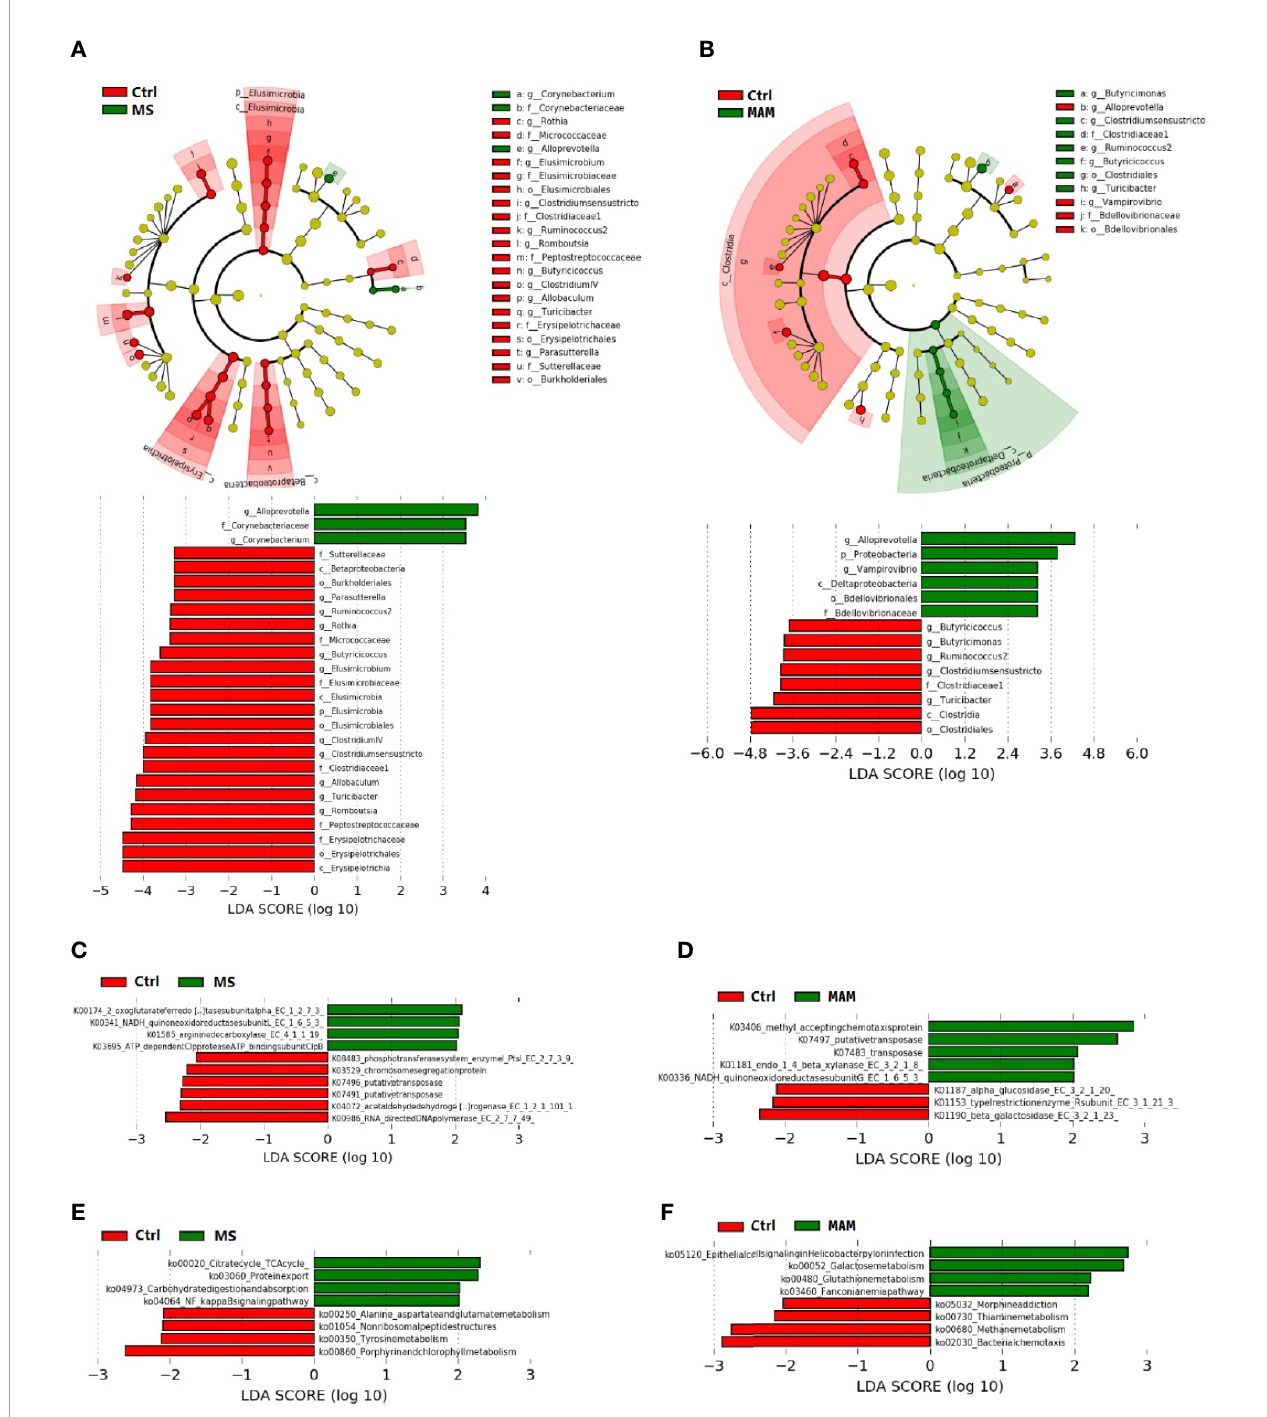
FIGURE 5 | Linear discriminant effect size (LEfSe) analyses comparing differentially abundant taxa and the KEGG-based ortholog functions and pathways between control and MS group communities and control and MAM group communities. (A, B) The differences in gut microbiota taxa between different model groups. The phylogenic relationship of the taxon with differences were shown in the cladogram. (C, D) Differences of KEGG-based ortholog (KO) inferred functions in gut microbiota between different model groups. (E, F) Differences in KO pathways predicted from gut microbiota compositions between different model